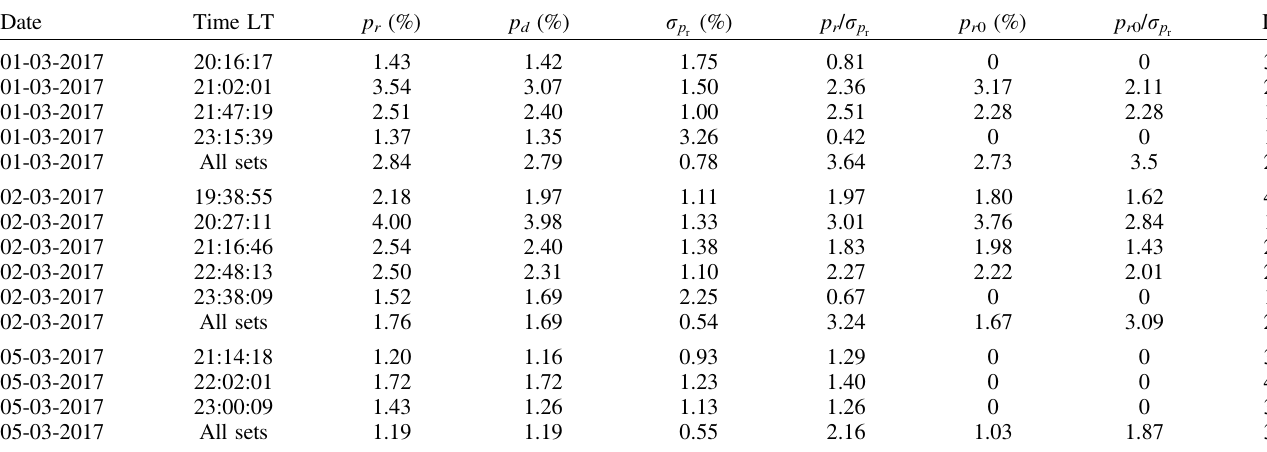
Table 1. Results of the DoLP measurements during the three days in March 2017.